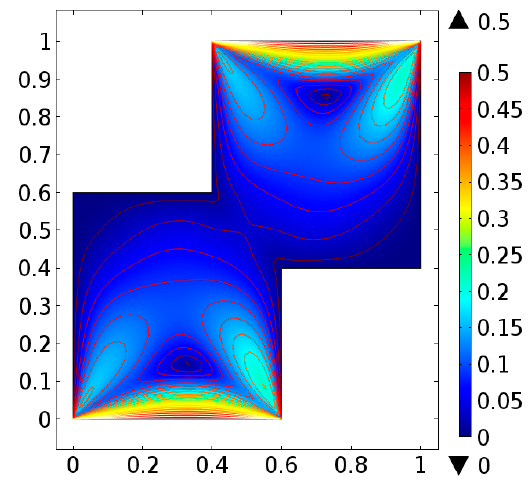
Figure 22. Velocity distribution at Re = 100 for case-II.